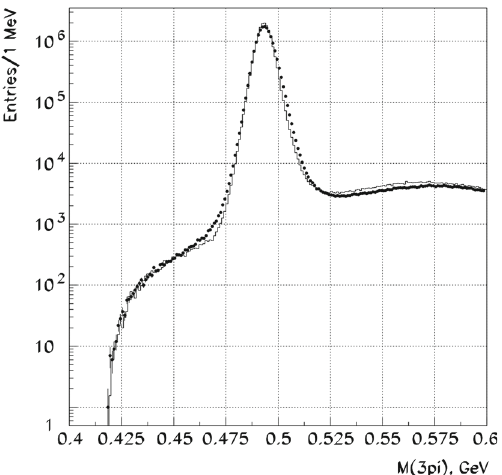
Fig. 6 The invariant mass distribution of three charged pions for the data (black circles) and for the Monte Carlo for the six main channels of the charged kaon decay